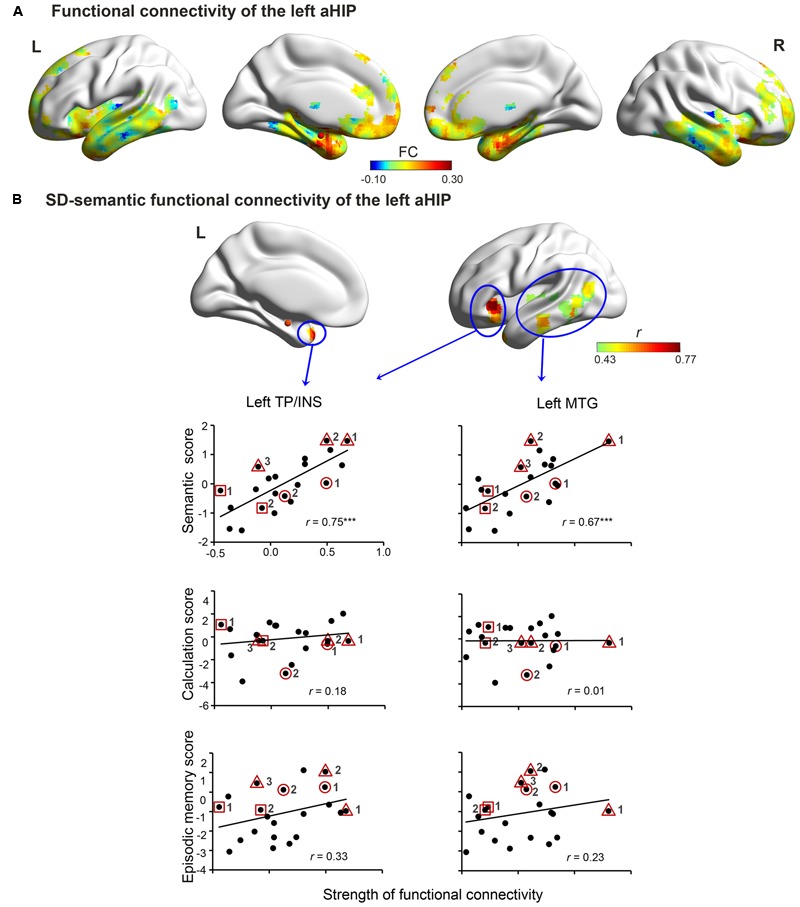
Left aHIP-seeded functional connectivity in the SD brain. The connectivity includes raw connectivity (A) and SD-semantic deficit-relevant connectivity (B) (AlphaSim corrected p < 0.001). In (B), row 1 illustrates the correlated connectivity brain map. Rows 2, 3, and 4 present the correlation diagrams of connectivity strength with semantic scores, number calculation scores, and episodic memory scores, respectively. The red spheres denote the left aHIP seed. ∗∗∗p < 0.001. Full names of the abbreviations are provided in Table 2. The meaning of the geometric figures and numbers circling the dots see Figure 1.